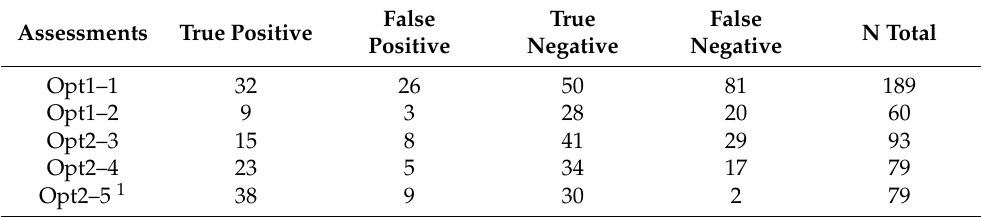
Table 2. Number of true positives, false positives, true negatives and false negatives for four performance assessments.